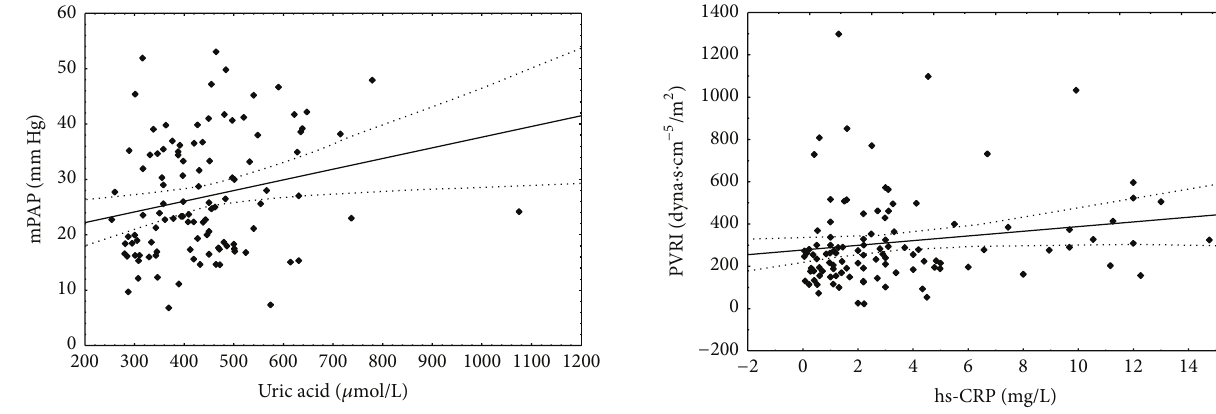
Figure 4: Correlation between hs-CRP concentration and pul- monary vascular resistance index. Spearman 𝑟 = 0.236 ; 𝑃 < 0.05